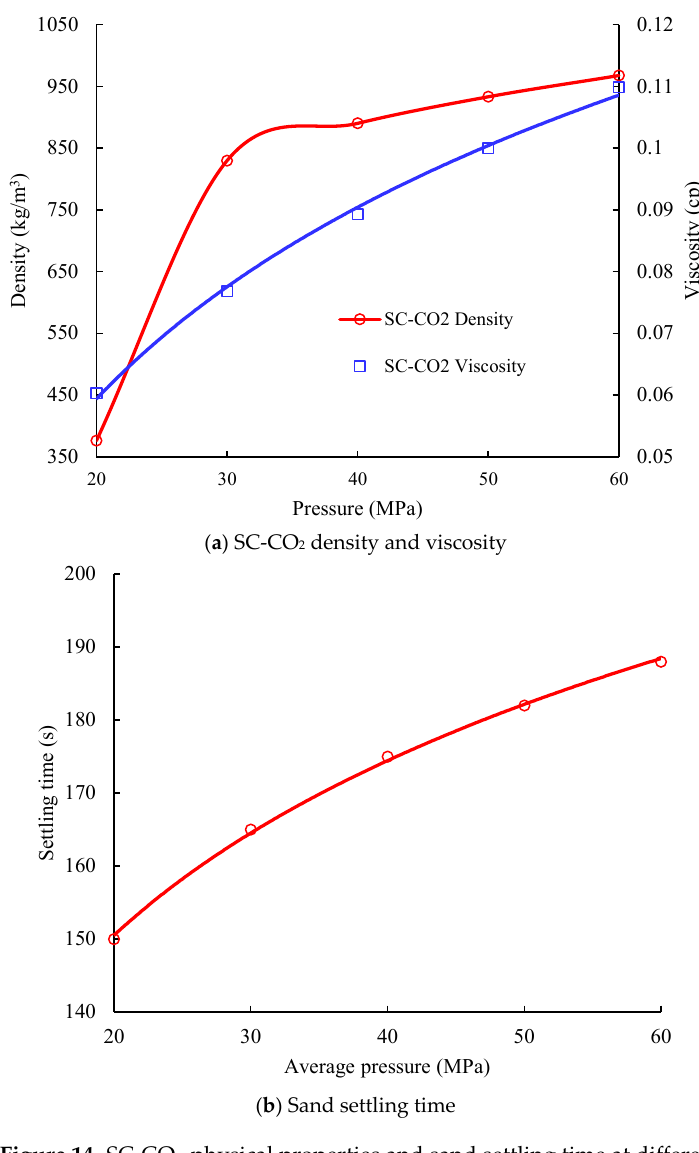
Figure 14. SC-CO 2 physical properties and sand settling time at different average pressures.